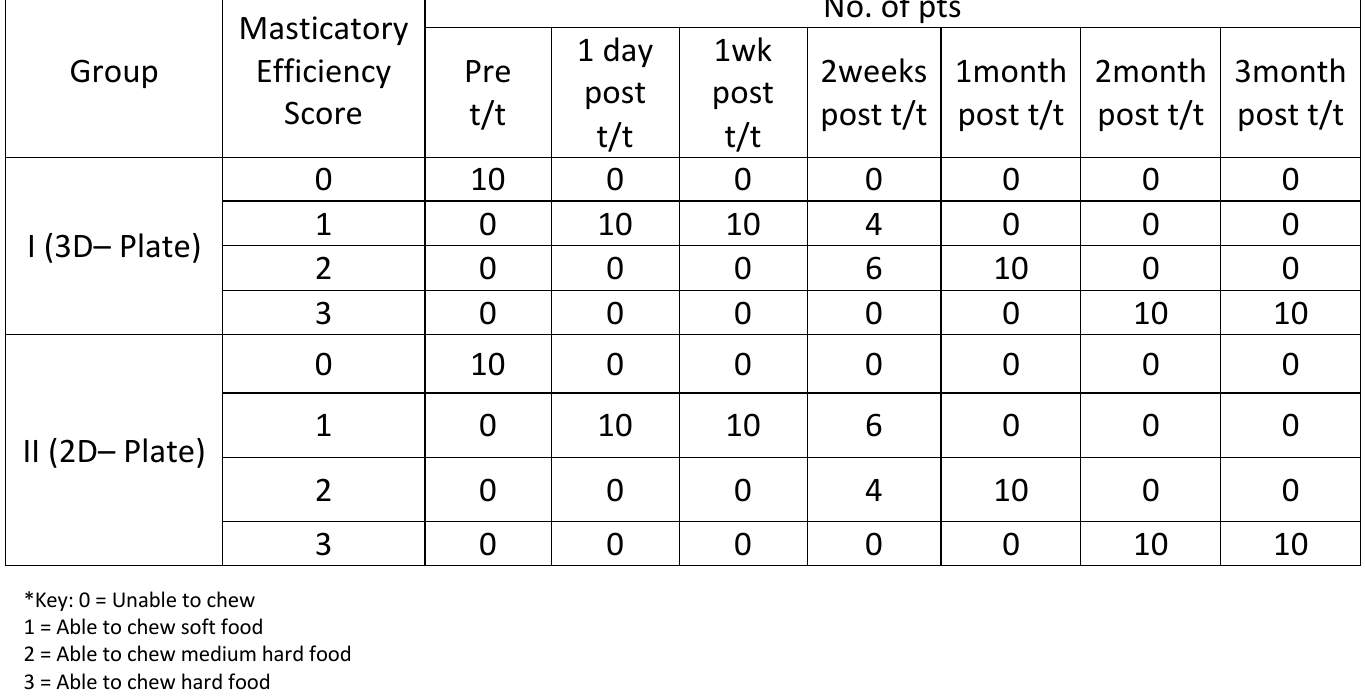
and 19.5 mm in group 2, which increased to 23.1 mm and 20.2 mm for group 1 and group 2 respectively immediately postoperatively. No